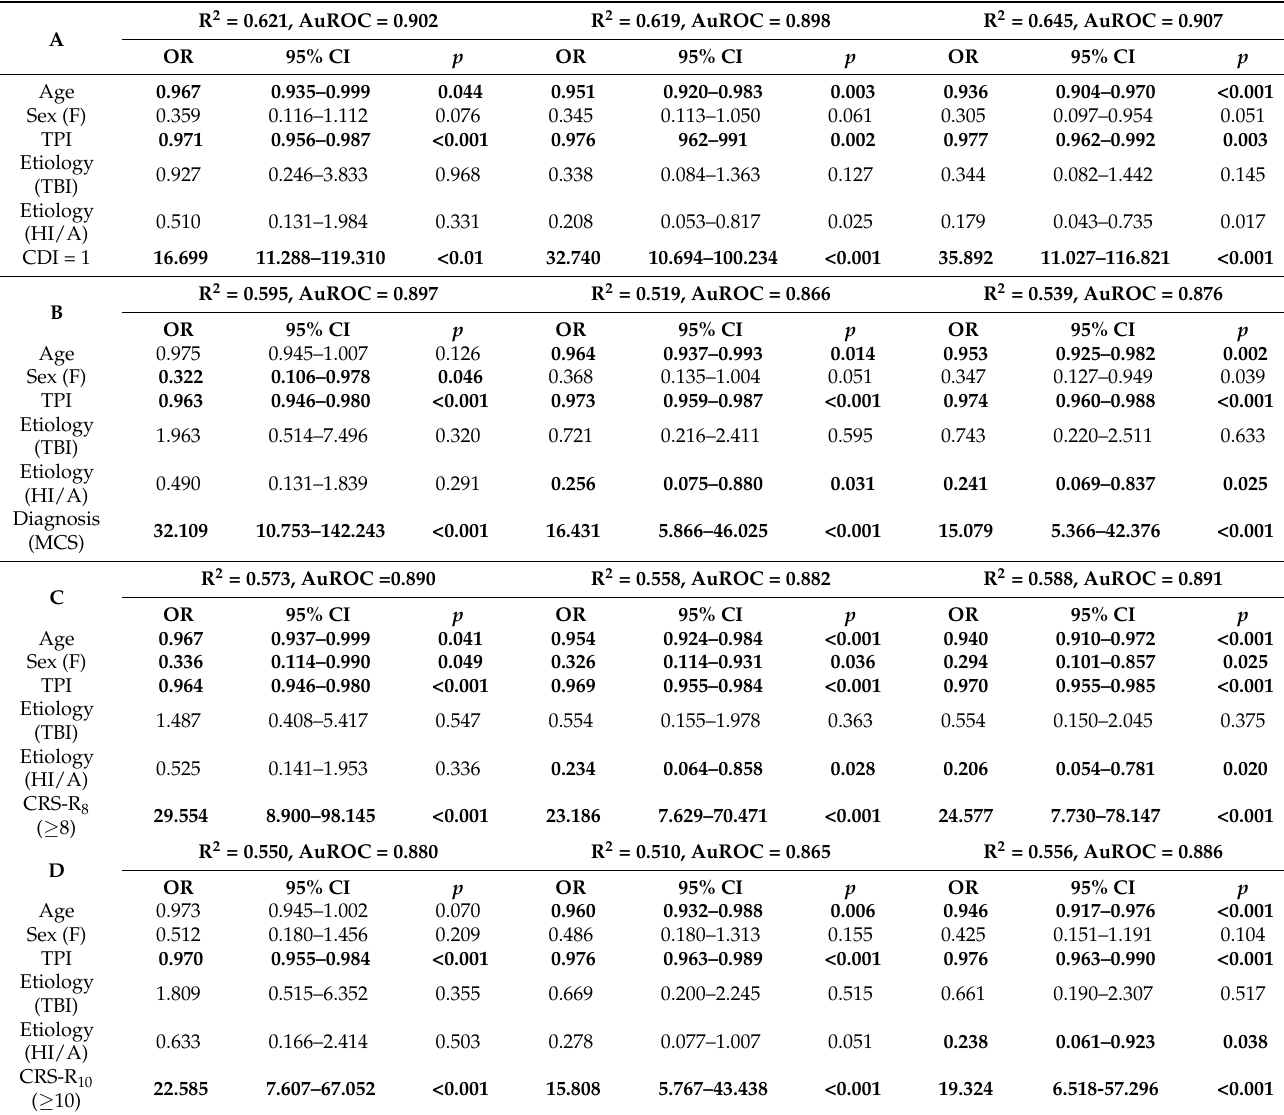
Table 4. Multivariate logistic regressions for predicting recovery of full consciousness at 6, 12, and 24 months after brain injury. Panels A, B, C, D, and E indicate regressions including the CDI, the clinical diagnosis, the CRS-R 8 , the CRS-R 10 , and the CRS-R total score, respectively. First, second, and third columns refer to the analysis targeting 6-, 12- and 24- months outcomes,